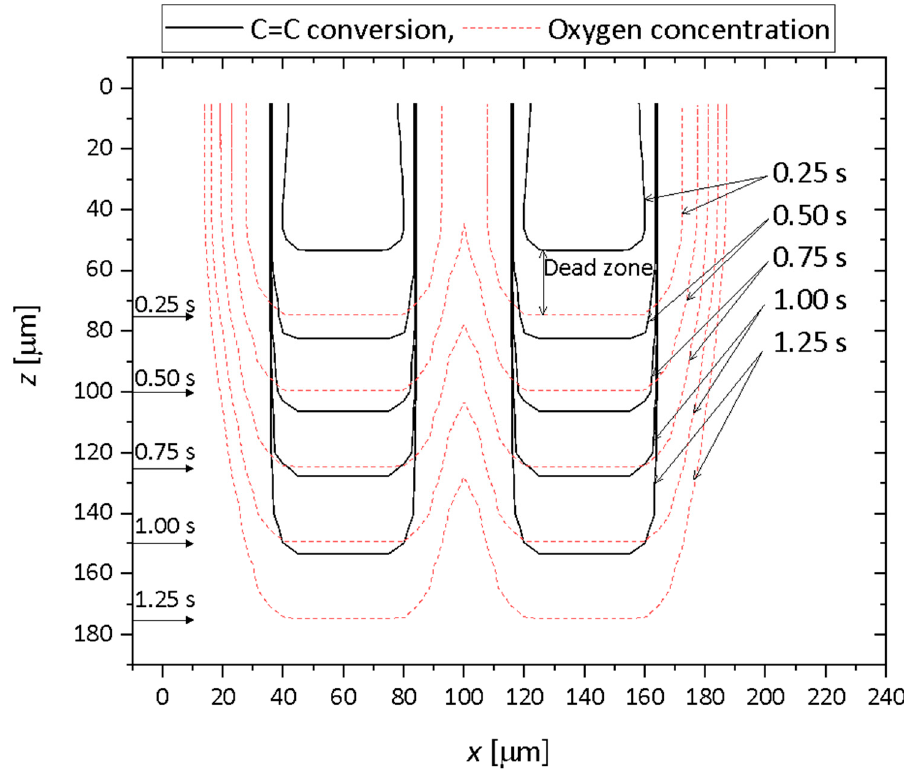
Figure 4. Superposition of the contour plot of normalized oxygen concentration of 0.9 and C = C bond